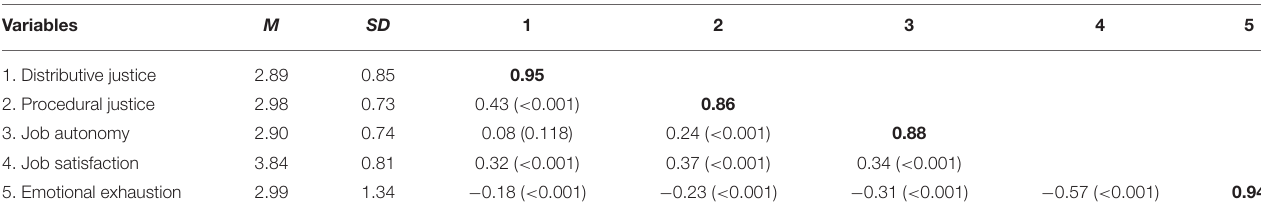
TABLE 2 | Means, standard deviations, intercorrelations, and Cronbach’s alpha coefficients of Study 1 variables. Variables M